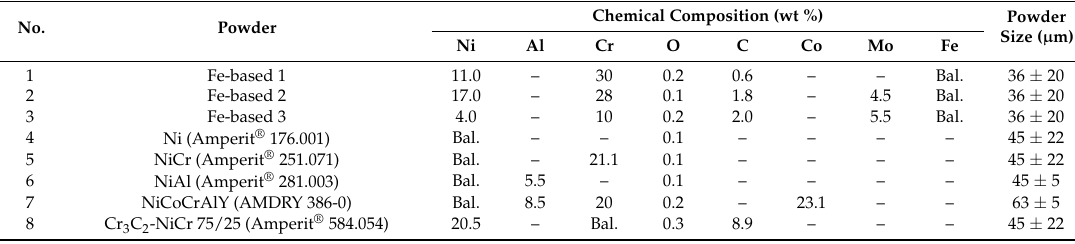
Table 1. Chemical composition and particle-size distribution of the